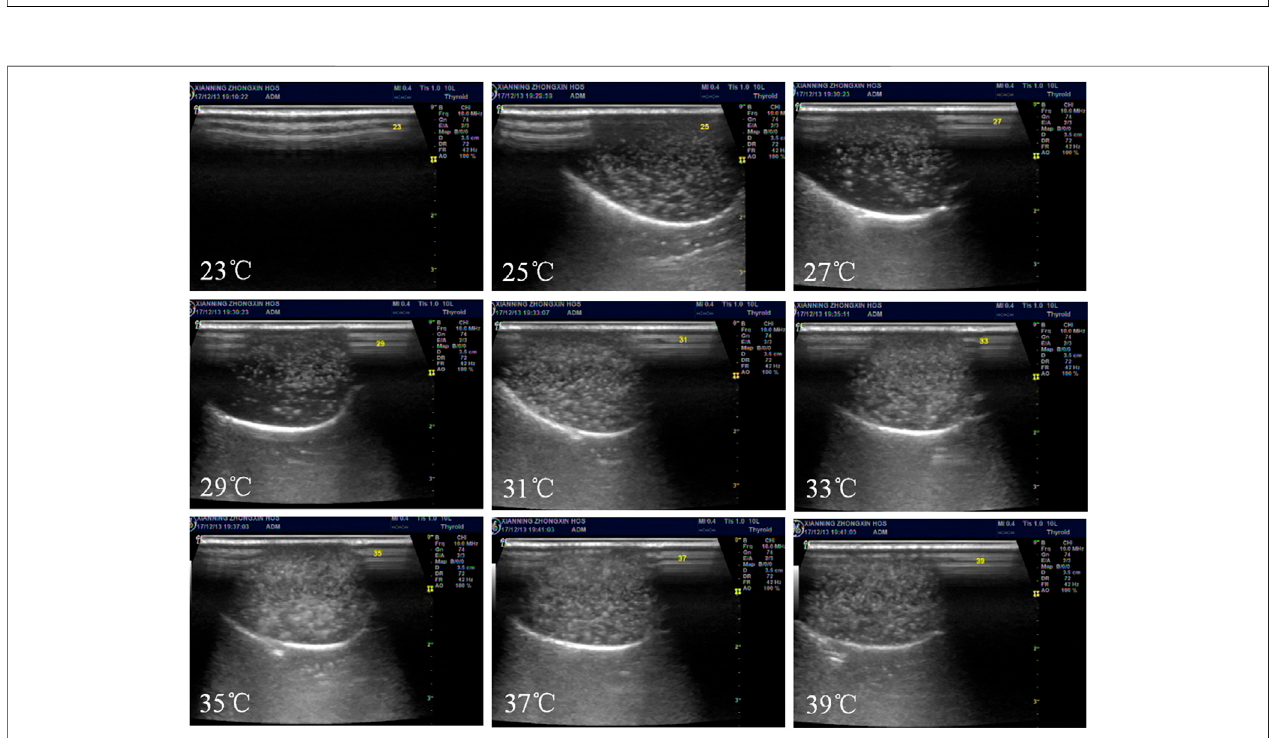
Figure 5 | In vitro ultrasonic images of Lf – PLLA NBs in latex gloves mold. Temperature was increased from 23 to 39 ° C at an interval of 2 °